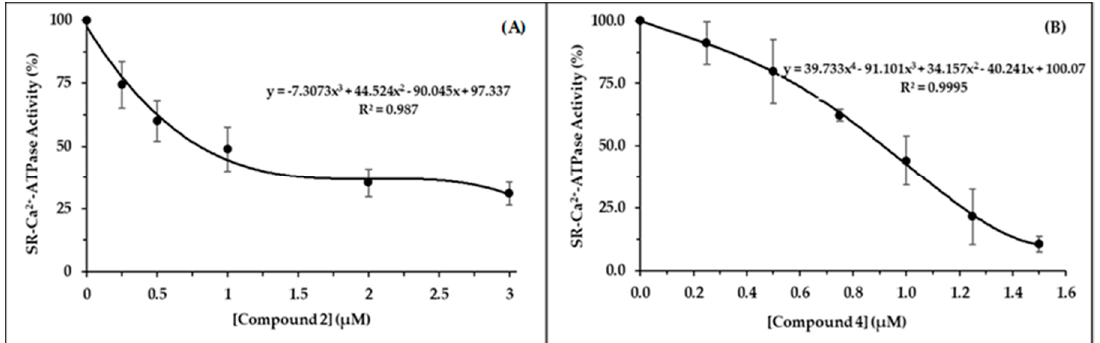
Figure 2. Inhibition of Ca 2 + -ATPase activity by gold compounds 2 ( A ) and 4 ( B ). Ca 2 + -ATPase was measured spectrophotometrically at 340 nm and 25 ◦ C, using the coupled enzyme pyruvate kinase / lactate dehydrogenase assay. The experiments were initiated after the addition of 10 µ g / mL calcium ATPase. Data are plotted as means ± SD. The results shown are the average of triplicate experiments carried out in distinct preparations.